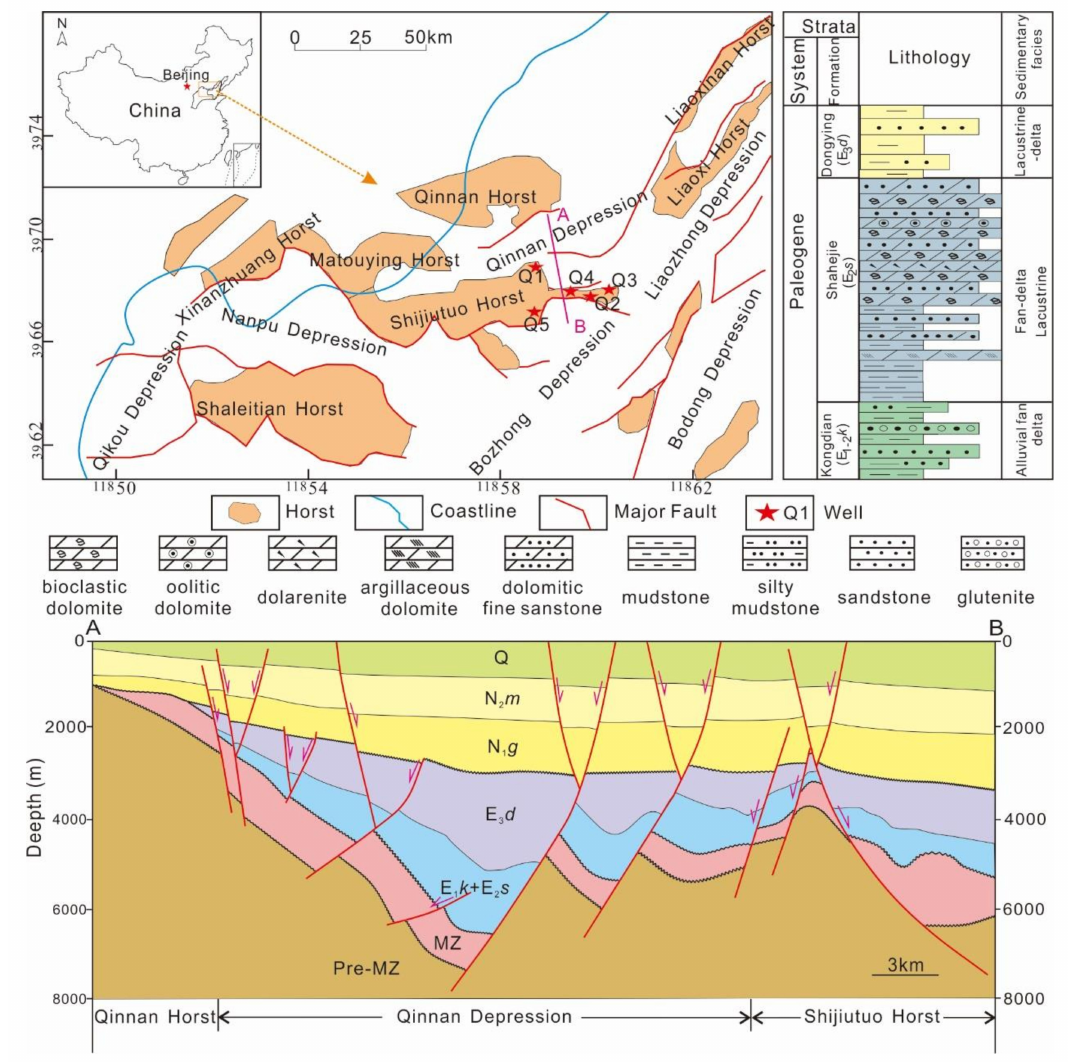
Figure 1. Map showing the structure of the study area and a lithological section of the Shahejie